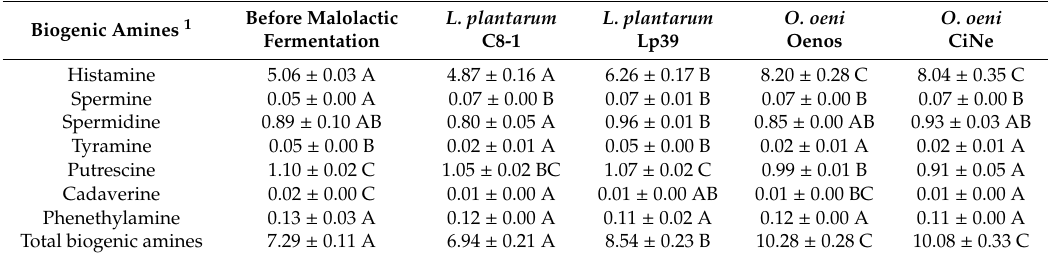
Table 2. Biogenic amines in Cabernet Gernischt wine before and after malolactic fermentation using L. plantarum (C8-1 and Lp39) and O. oeni (Oenos and